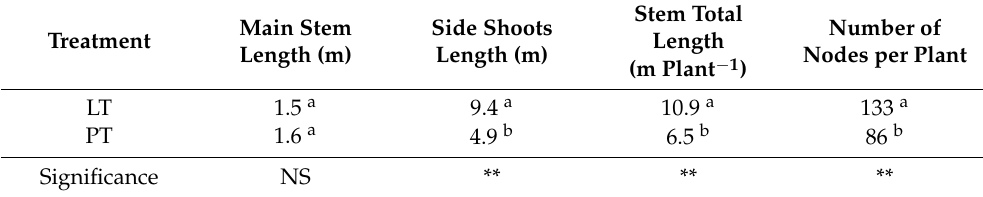
Table 2. Effect of training methods on cucumber plant